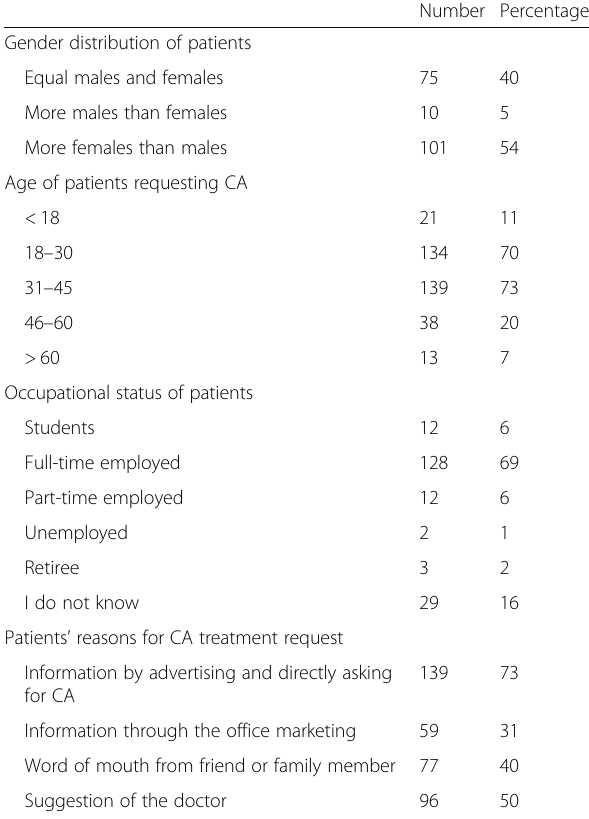
Number Percentage